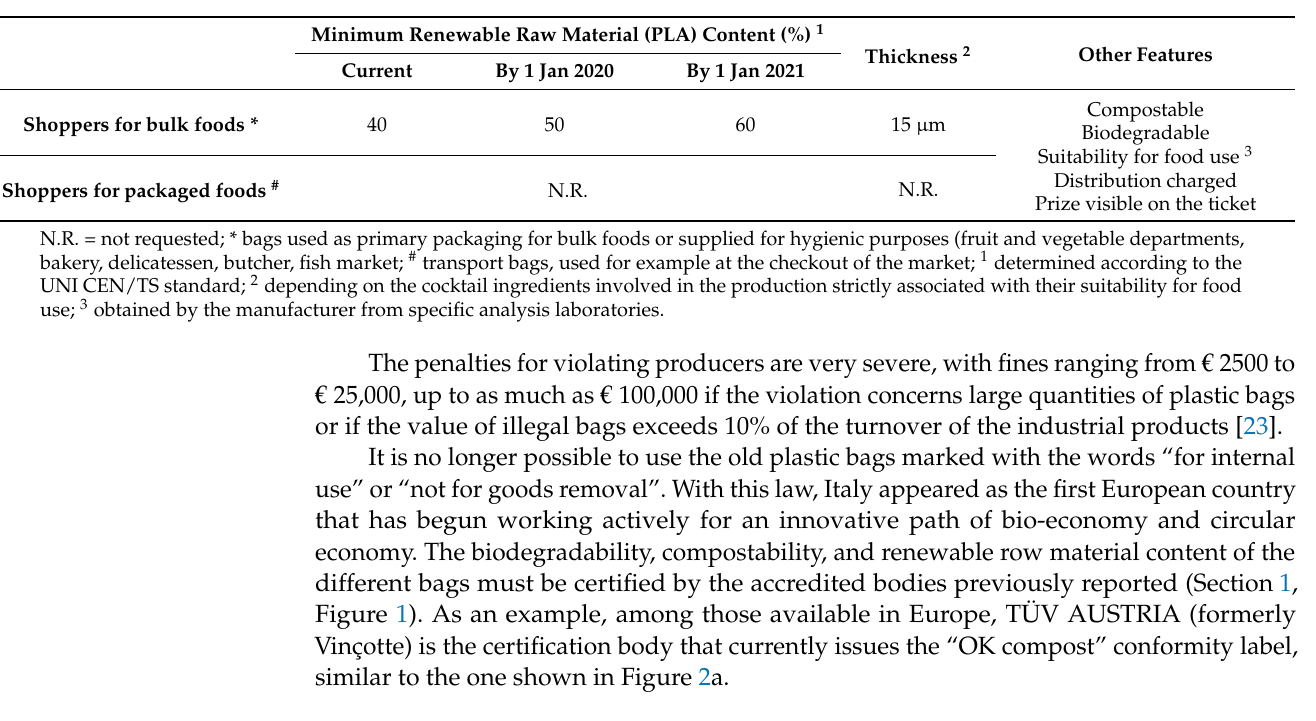
Table 4. Main requirements for shopper bags intended for the transport of packaged food or as primary packaging for bulk food [23].